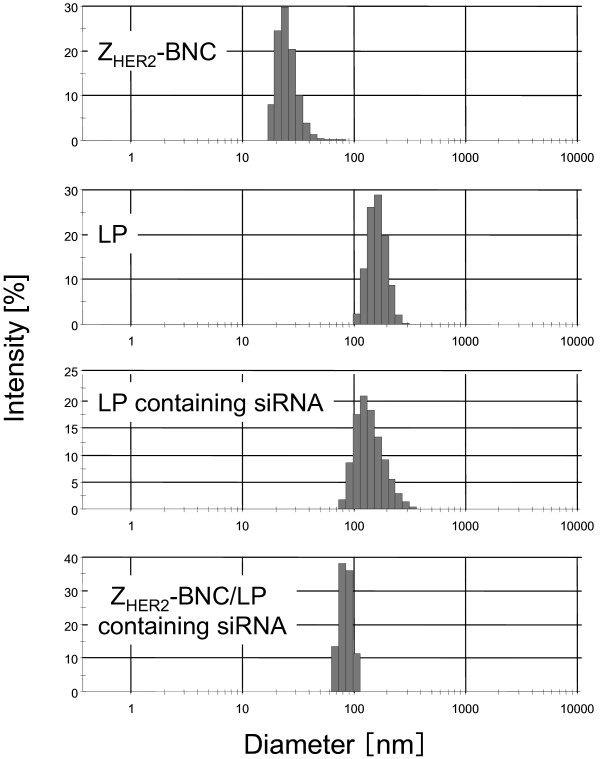
The DLS analyses of ZHER2-BNC, LP, LP containing siRNA and ZHER2-BNC/LP containing siRNA.